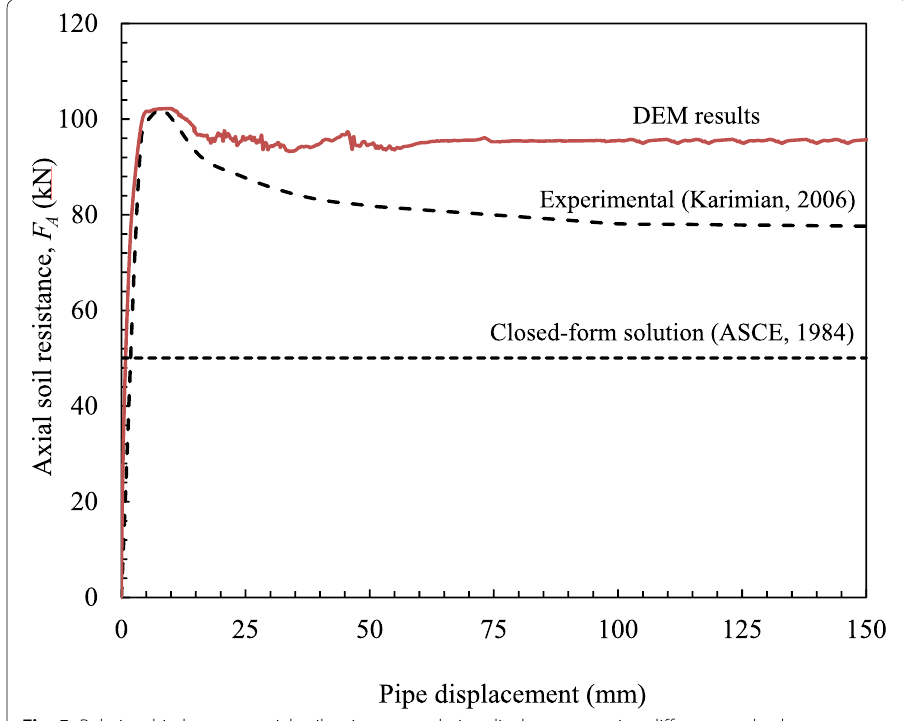
Fig. 5 Relationship between axial soil resistance and pipe displacement using different methods